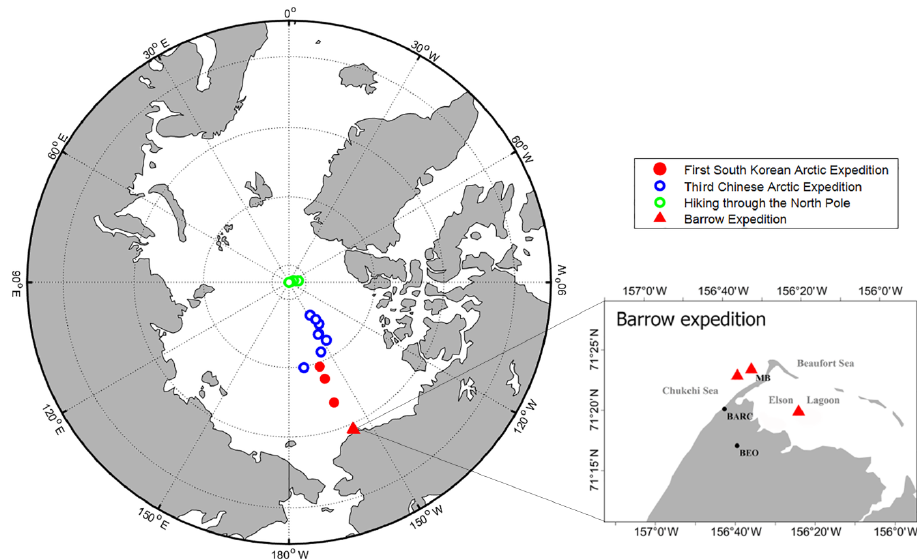
Figure 1. The locations of snow and ice layer sampling and the measurements of snow thickness and density in this study. Barrow expeditions include the field measurements carried out in the Elson Lagoon in 2015, and in the Chukchi Sea in 2017 and 2018; the third Chinese Arctic Expedition was conducted over the Canada Basin and the centre region of Arctic Ocean in 2008; the first South Korean Arctic Expedition was conducted over the Canada Basin in 2010; the North Pole Expedition refers to the first Chinese expedition hiking through the North Pole from 88 to 90 ◦ N in 1995 (Xiao et al., 1997). The open circle indicates the point at which the ice layer was observed. The solid triangles and circles mark the locations for both sampling and on-site